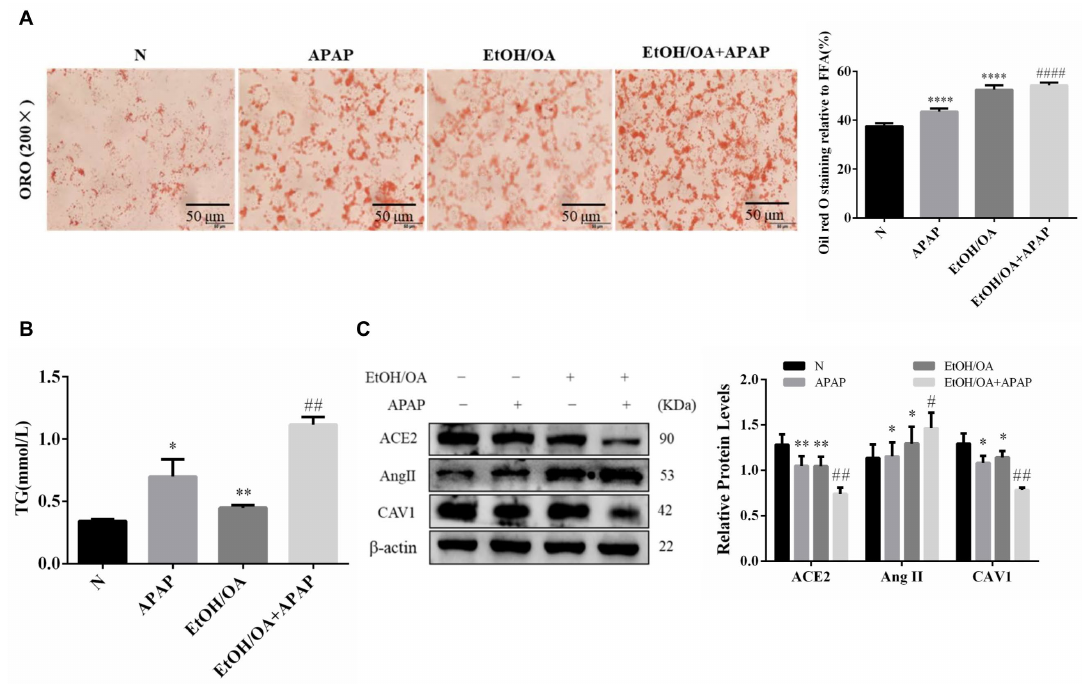
Figure 5. APAP aggravated lipid deposition and liver injury induced by alcohol and oleic acid in L02 cells, and the protein expression of the CAV1 and ACE2 were decreased while the Ang II was increased. ( A ) ORO staining in L02 cells (Scale bar = 50 µ m). ( B ) The TG levels treated with EtOH/OA and APAP. ( C ) Western blot analysis of ACE2, Ang II and CAV1 protein levels. (n = 3 independent experiments). * p < 0.05 vs. N group; ** p < 0.01 vs. N group; **** p < 0.0001 vs. N group; # p < 0.05 vs. APAP group; ## p < 0.01 vs. APAP group; #### p < 0.0001 vs. APAP group.